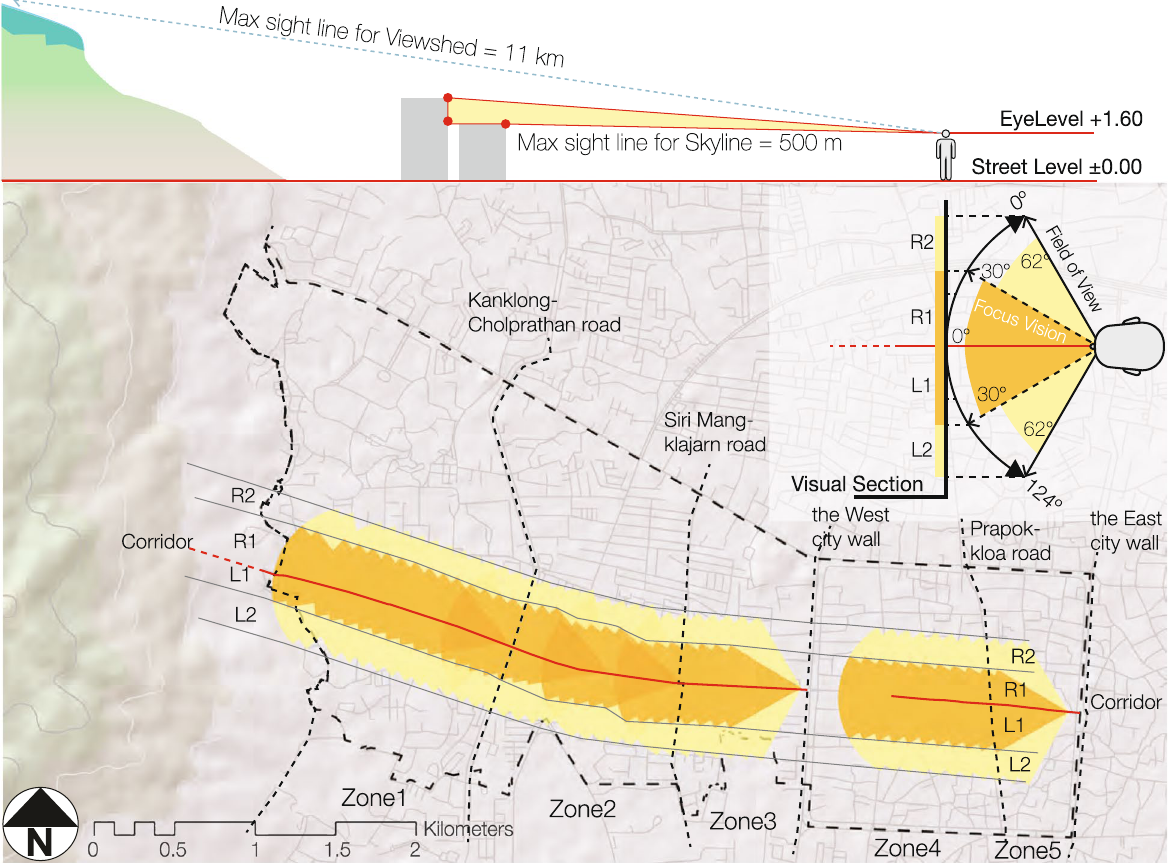
Fig. 3 Determination of zones and visual field sections (Source: the